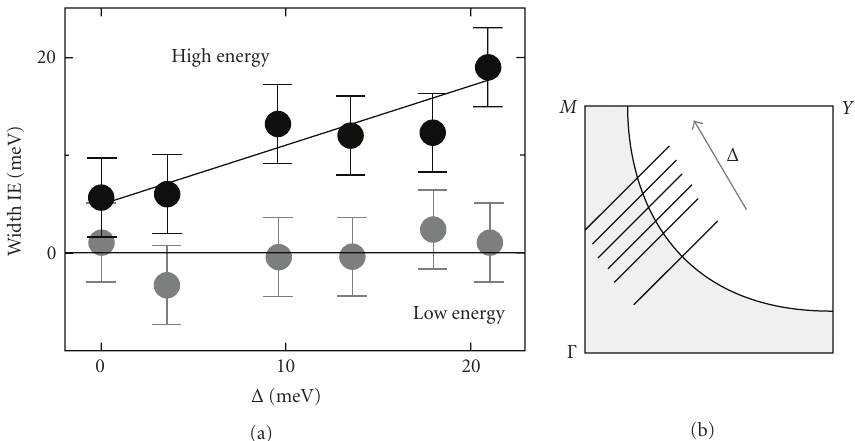
Figure 10: Isotope e ff ect on EDC widths determined from ARPES data taken at the slices indicated in the smaller panel (same as Figure 8) within the superconducting phase. The width change for each cut comes from an average over binding energies below and above the kink energy: low (70meV to 0) and high ( ∼ 250 meV to 70 meV) energies. These widths are plotted with respect to the isotope averaged superconducting gap, Δ , of each cut, showing little change at low energies but significant change above the kink energy. The figure is from [42].